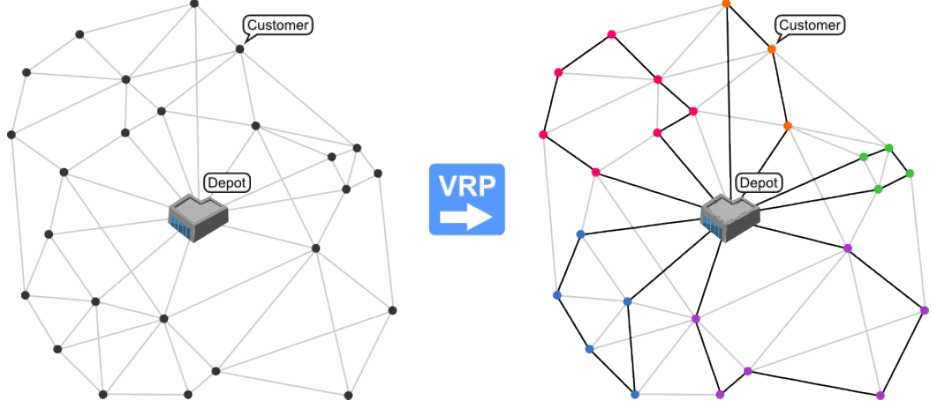
Figure 1. Example of a VRP with a valid solution